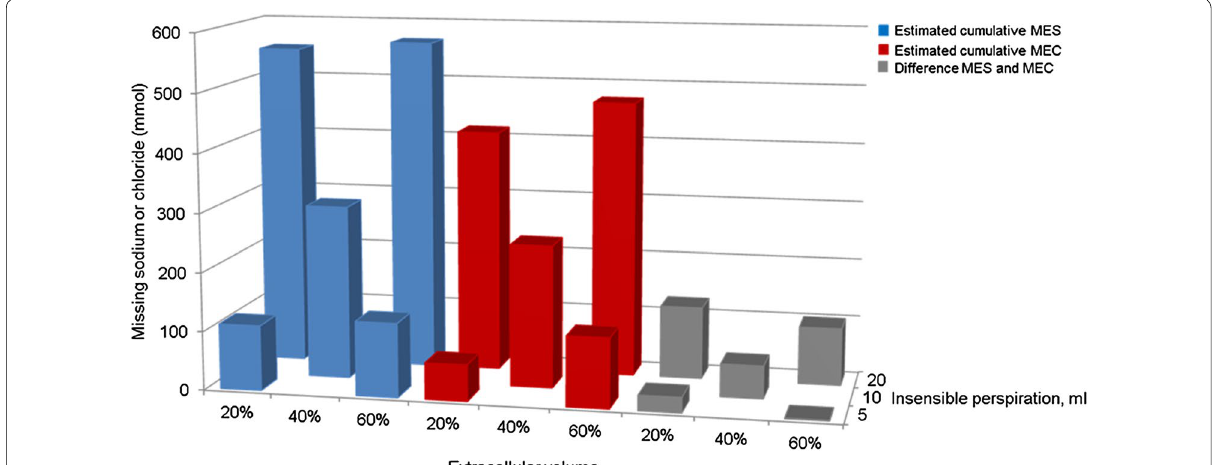
Fig. 3 Estimated cumulative MES and MEC according to different scenarios. Values are depicted as means. The calculated MES (blue), MEC (red) and their difference (light gray) on ICU day 4 according to the scenarios with different assumptions on perspiration and the size of the extracellular